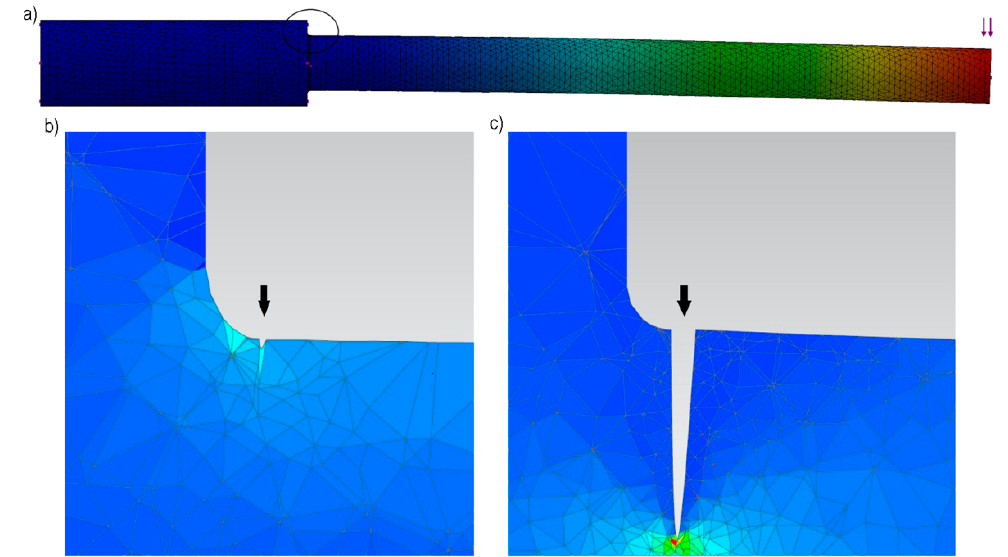
Figure 3. ( a ) Geometry used in FEM, showing the location of applied load; ( b ) small crack at notch root; ( c ) larger crack at the notch root.